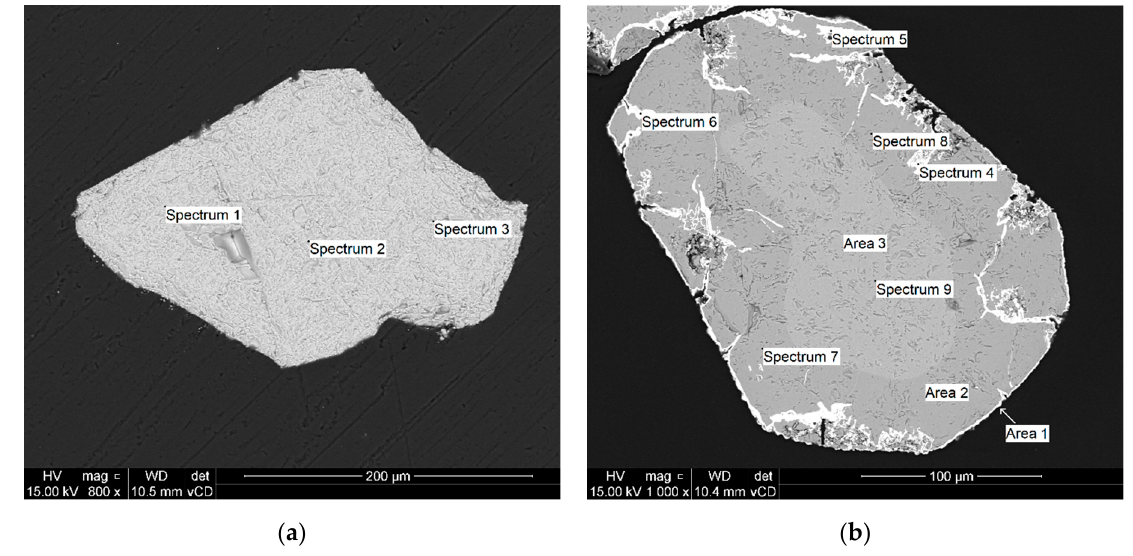
Figure 6. Backscattered electron SEM micrograph of chromite particles reduced at 1100 °C for 60 min at a 150 ( a ) and 750 mL/min ( b ) hydrogen flow rate.